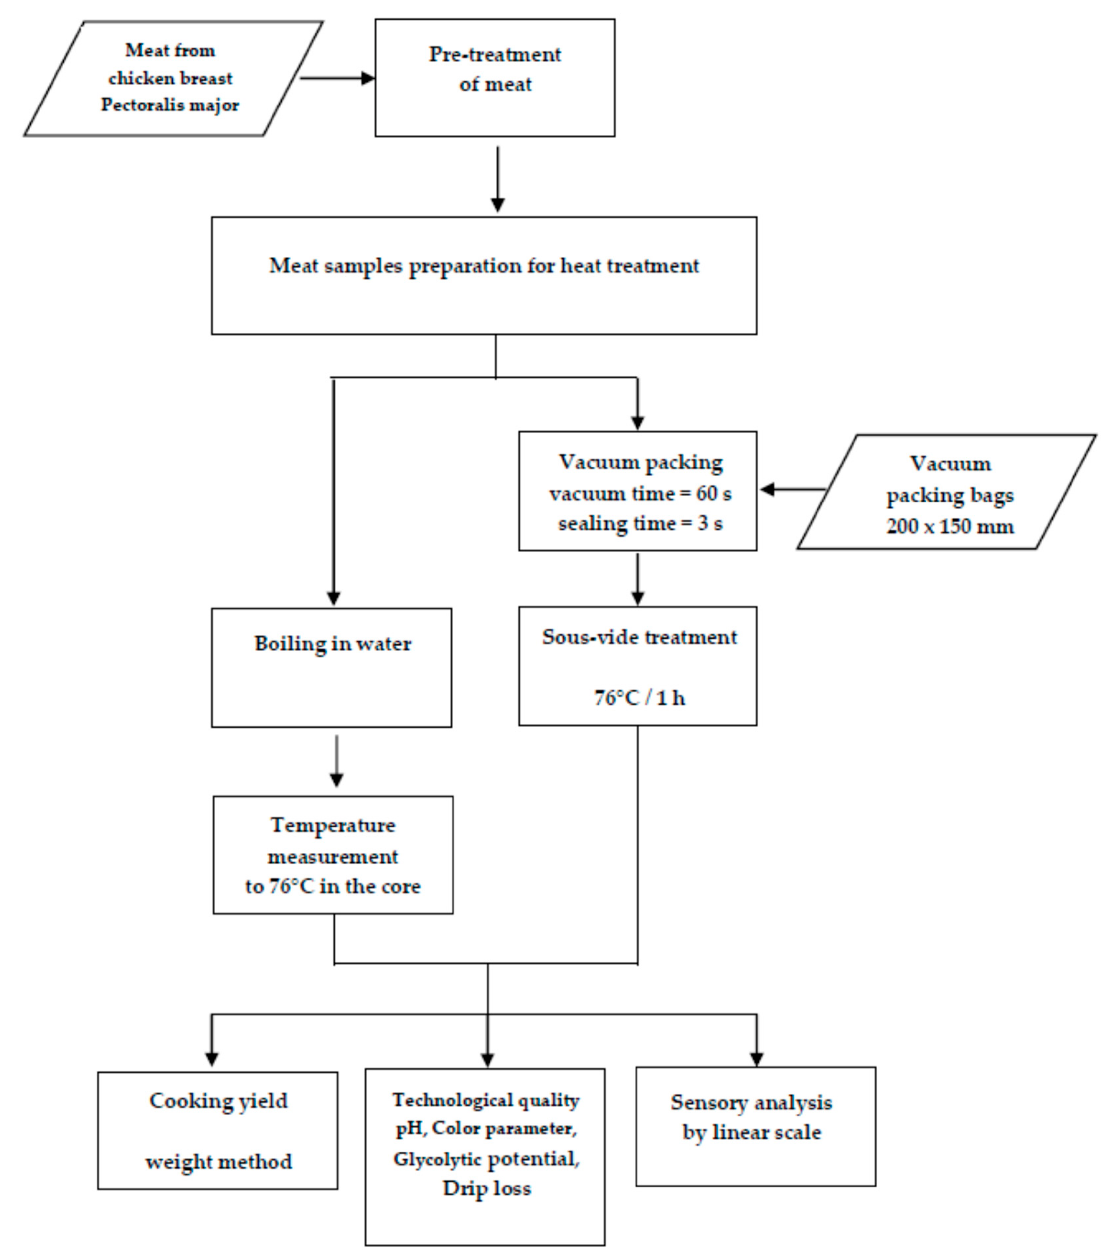
Figure 1. Research scheme.